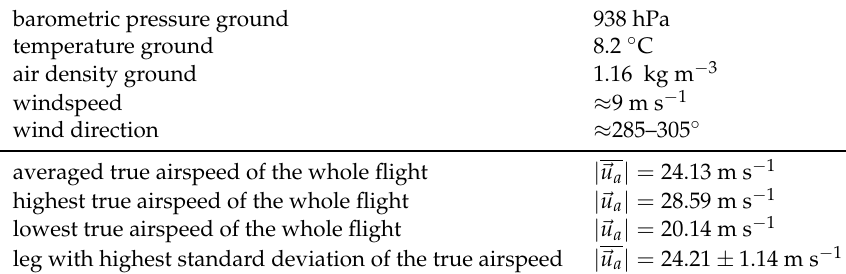
Table 3. Overview of the conditions during the COMPLEX